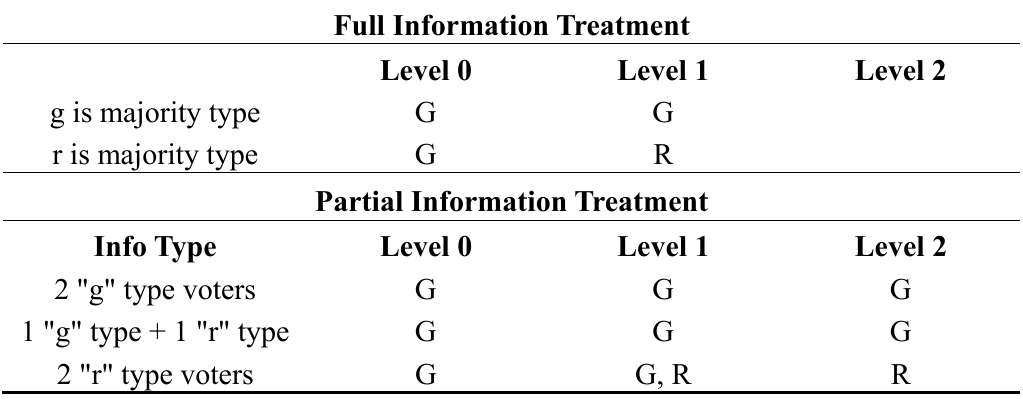
Table 3. Level- k cognitive reasoning process for g